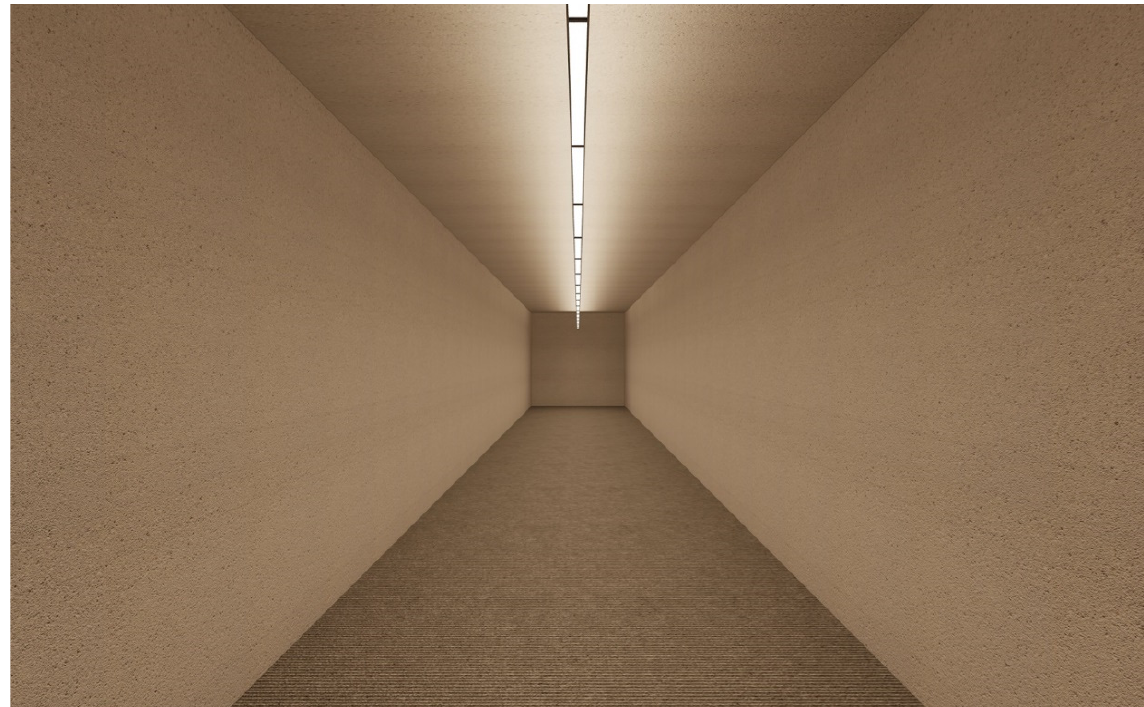
Figure 10. Computer simulation of corridor lighting for variant 7.